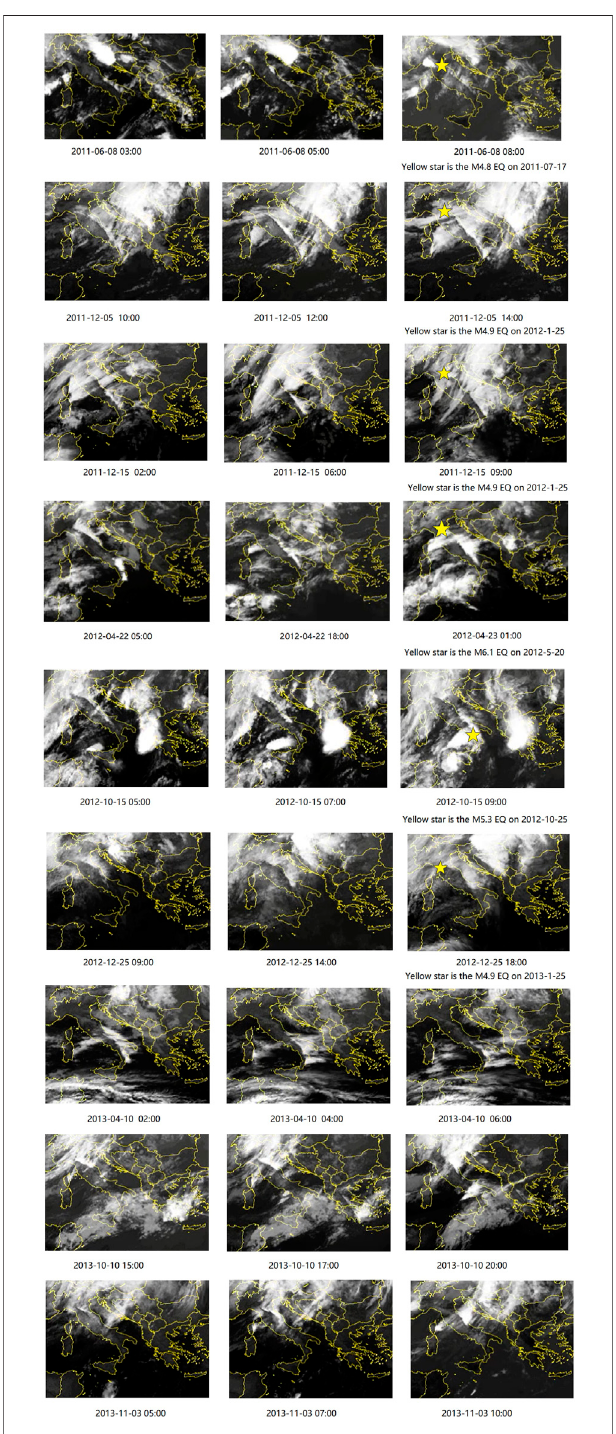
FIGURE 1 | Typical satellite cloud anomalies appeared over Italy main fault systems. The yellow star means the earthquake following the cloud anomaly. Note some cloud anomalies has no earthquake that followed.